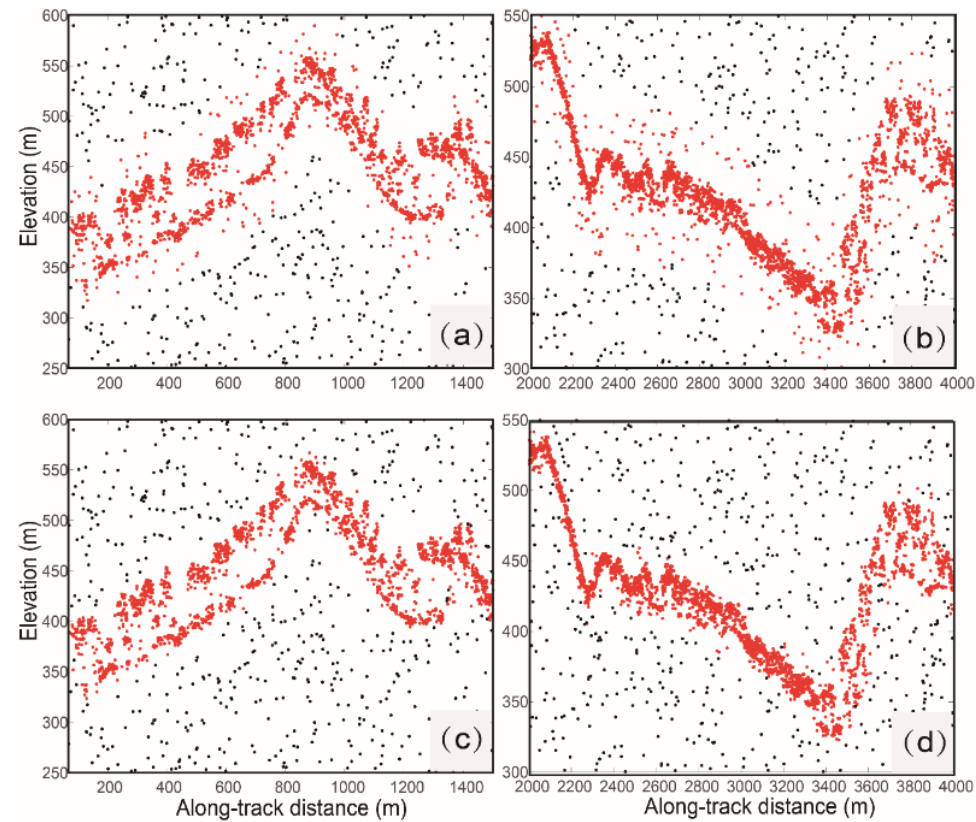
Figure 7. Partially enlarged views of test site A filtered by the LDS method ( a , b ) and the proposed method ( c , d ). Red dots represent signal photons; black dots represent noise photons.